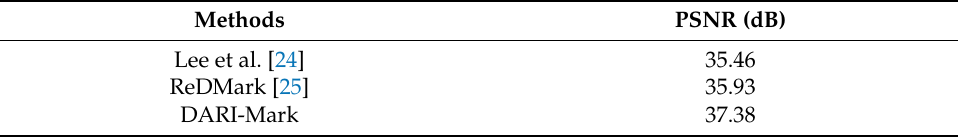
Table 2. PSNR values of three methods.